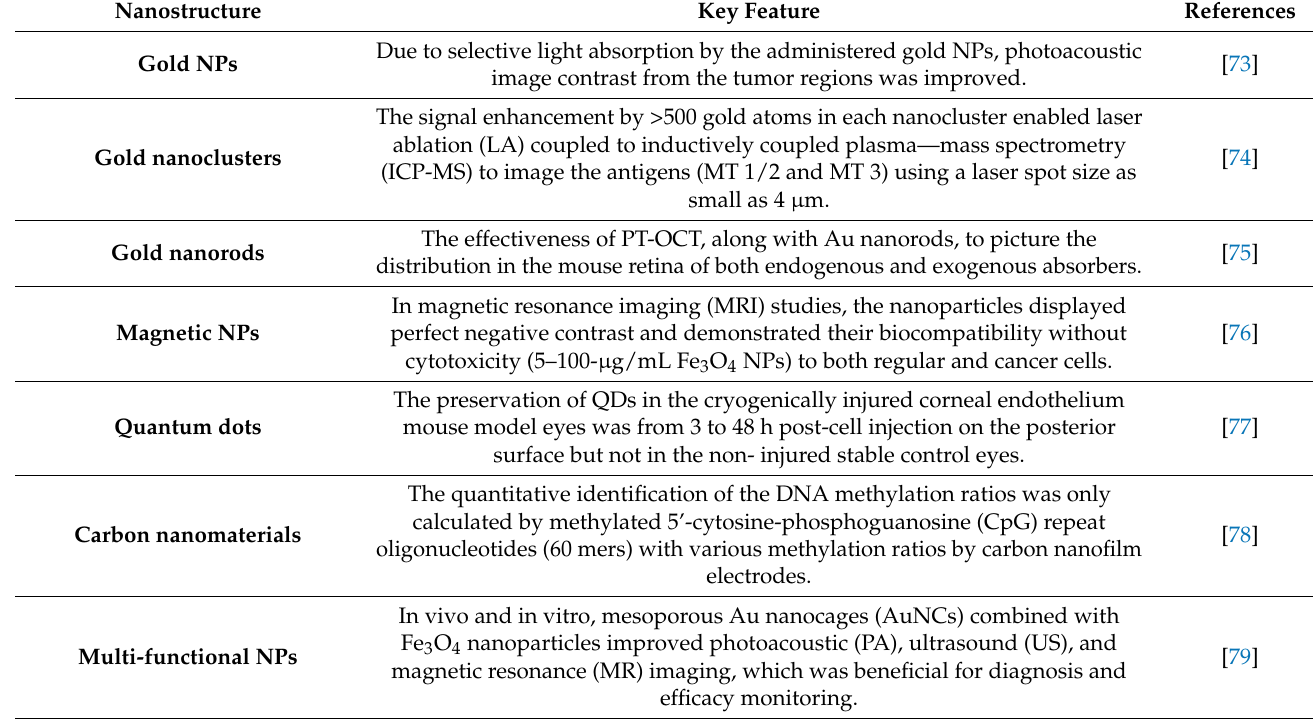
Table 1. Summary of several nanostructures in the diagnosis of retinoblastoma (RB). [NPs: nanoparticles, QDs: quantum dots, MT: metallothionein, PT-OCT: photothermal optical coherence tomography, and Au: gold].